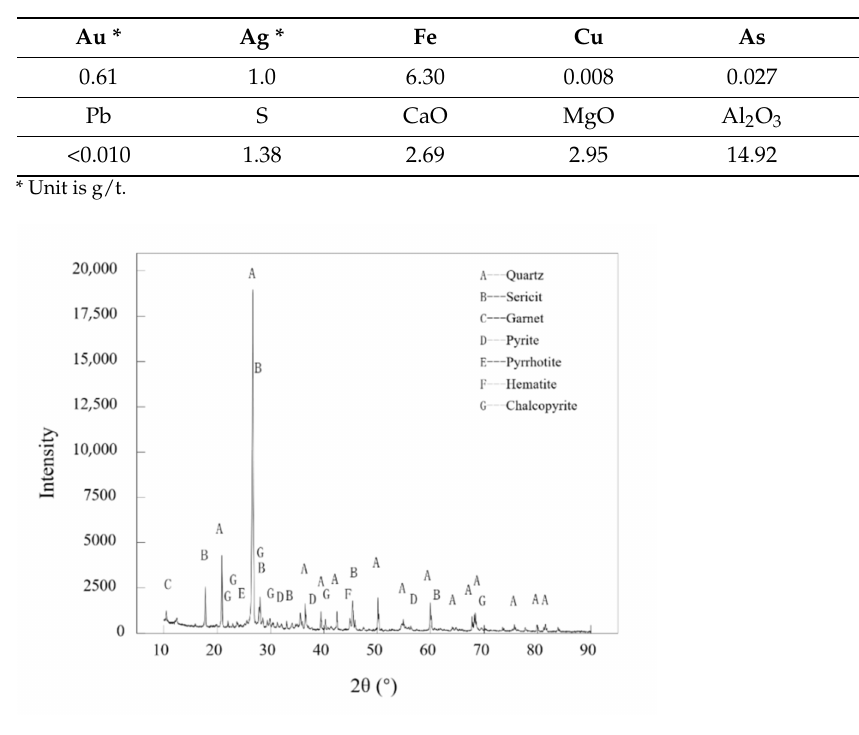
Table 1. Primary chemical components of the test sample (%).